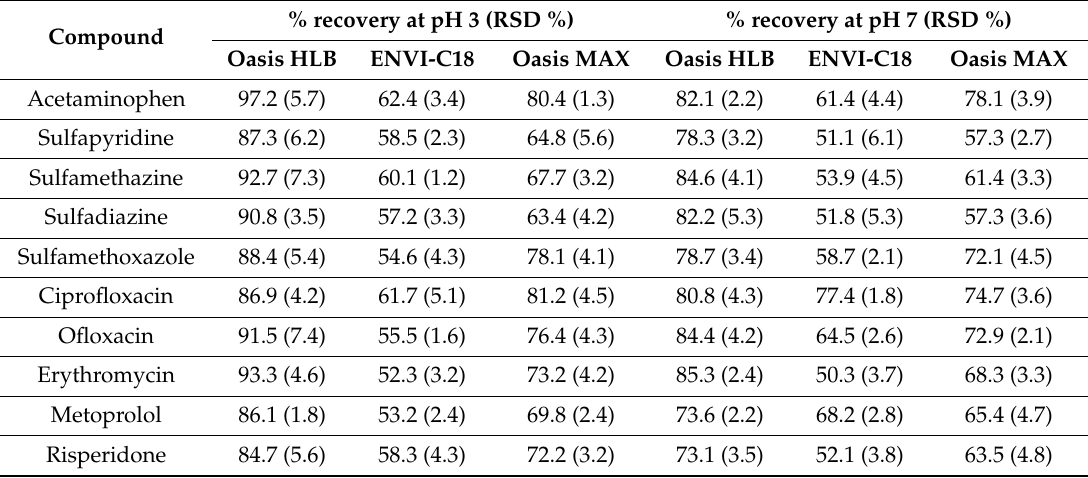
Table 2. Recoveries of the selected pharmaceuticals using Oasis HLB, ENVI-C18 and Oasis MAX at two pH values (concentration 15 ng/L, n =